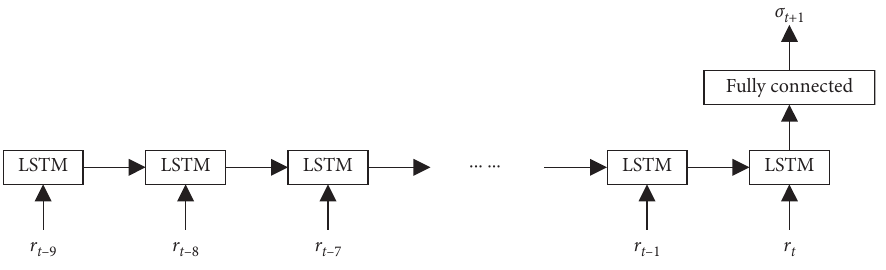
Figure 3: Architecture of our LSTM